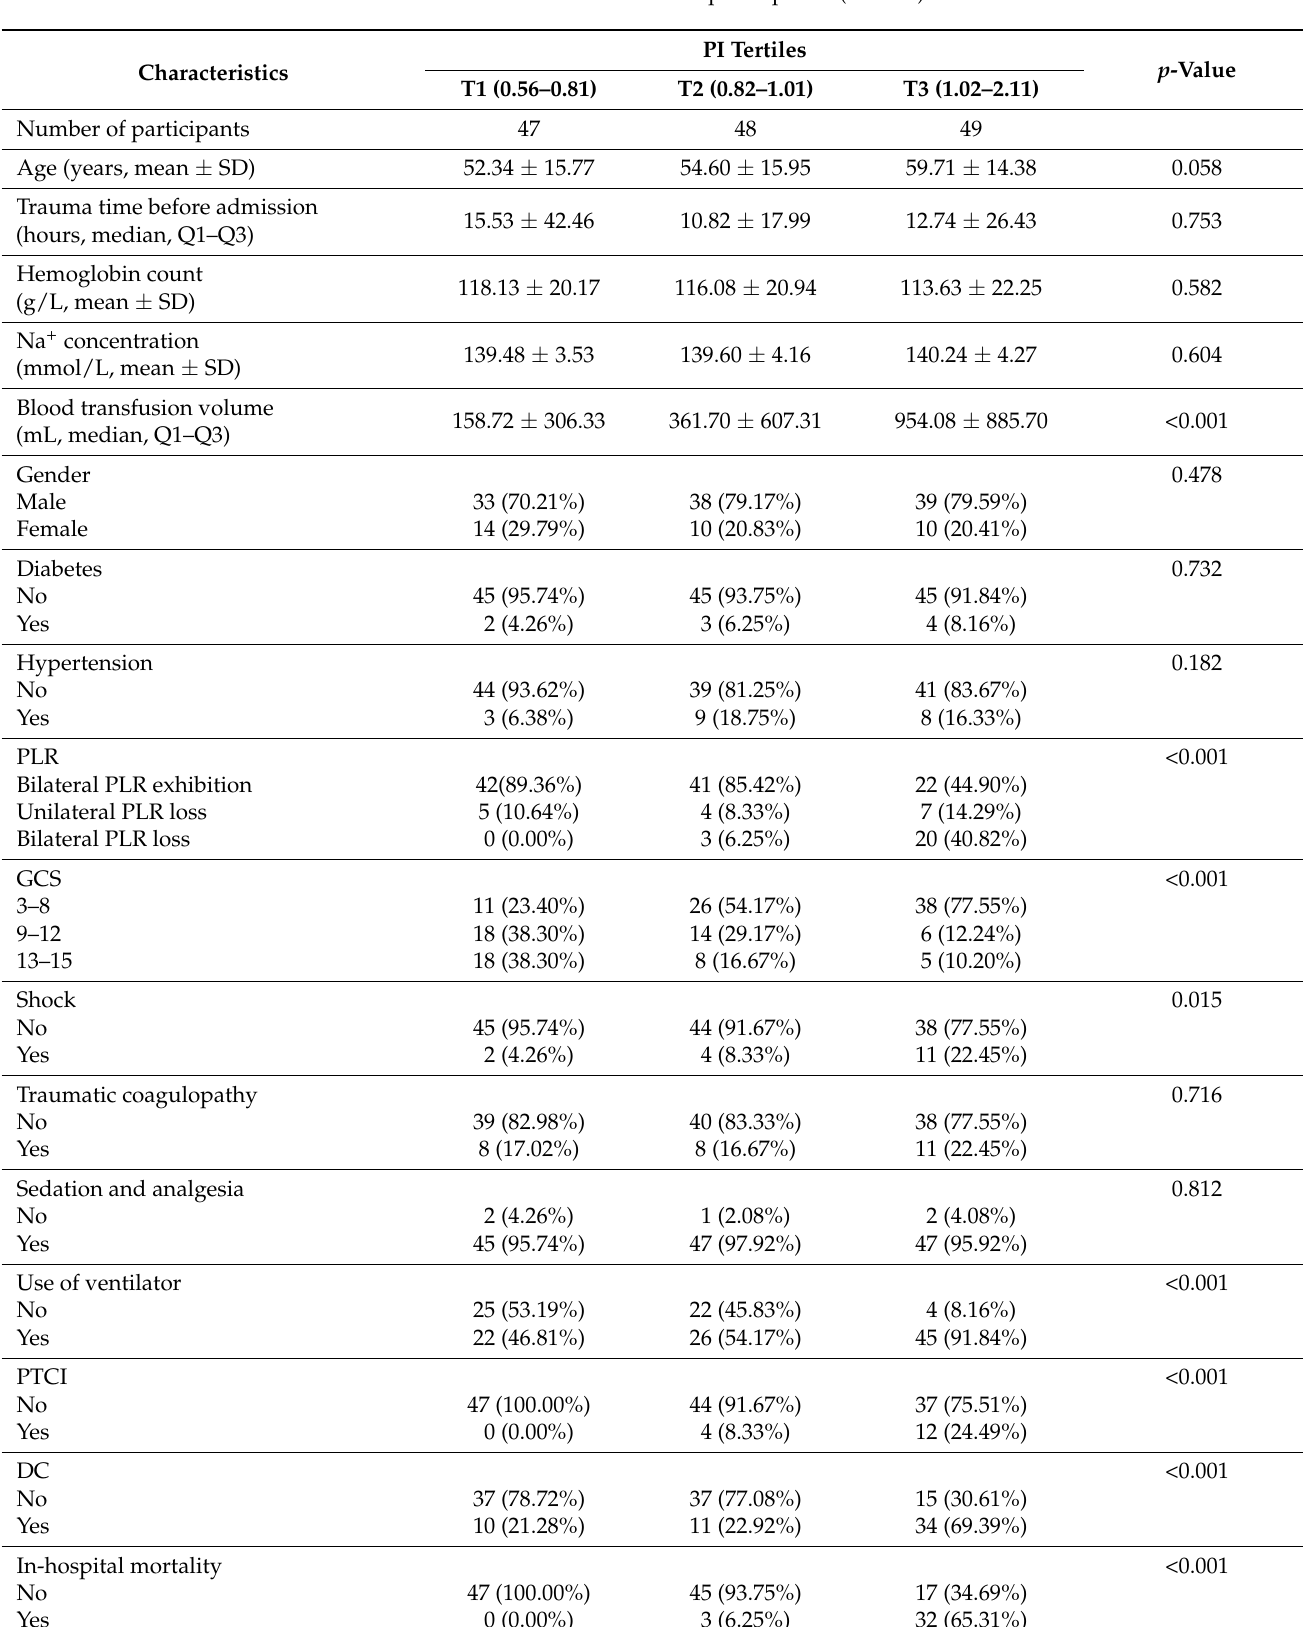
Table 1. Baseline characteristics of the participants. ( n =